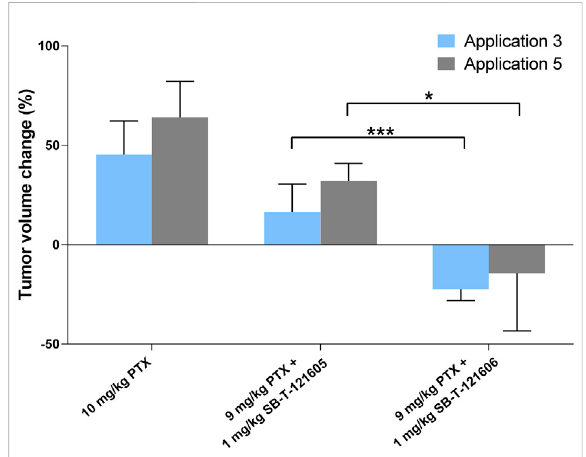
FIGURE 11 Comparison of in vivo ef fi cacy of SB-T-121605 and SB-T- 121606 combined with PTX. Comparison of proportional (%) change of tumor volume during experiment. Ef fi cacy was compared between the groups treated with a/10 mg/kg PTX, b/combination of 9 mg/kg PTX + 1 mg/kg SB-T-121605 and